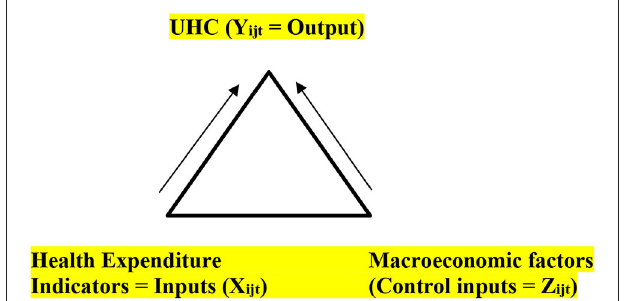
FIGURE 1 | Conceptual framework. Input-output relation of universal health coverage (UHC) with health expenditure and macroeconomic